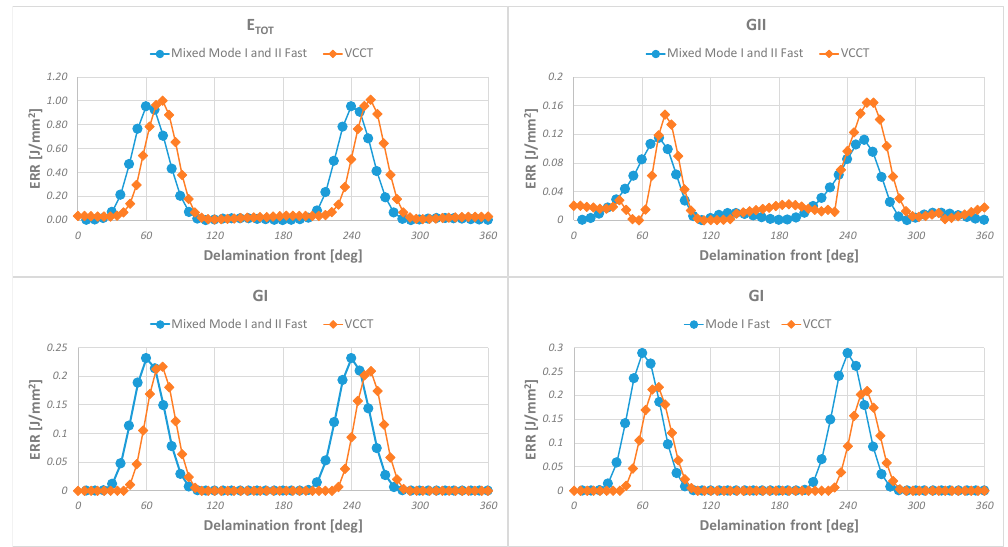
Figure 17. Comparison of strain energy release rate (SERR) distribution for SS#1 damage configuration.